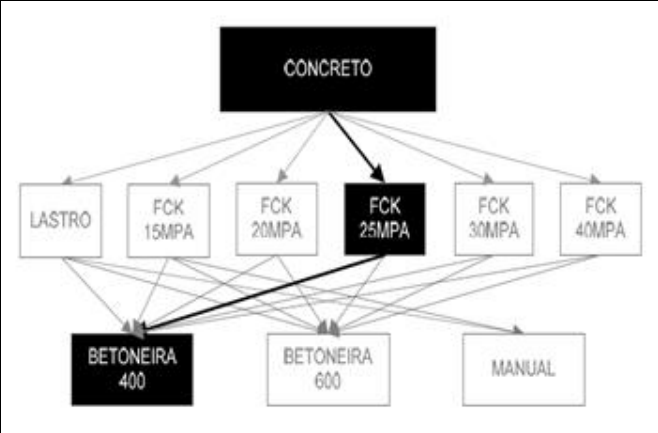
Figura 2: Árvore de fatores do serviço de produção do concreto. Fonte: SINAPI (caderno técnico),